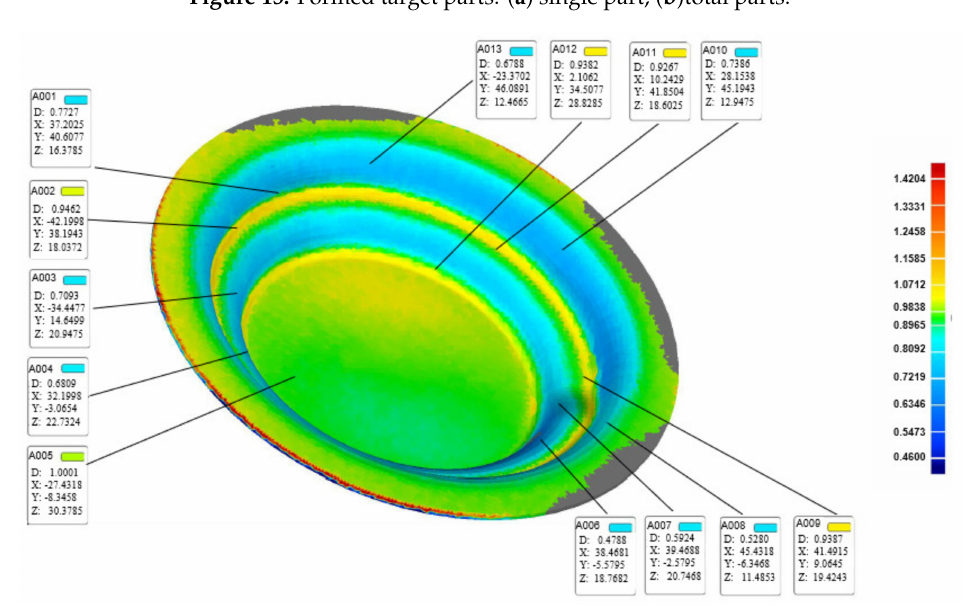
Figure 15. Formed target parts: ( a ) single part, ( b )total parts.